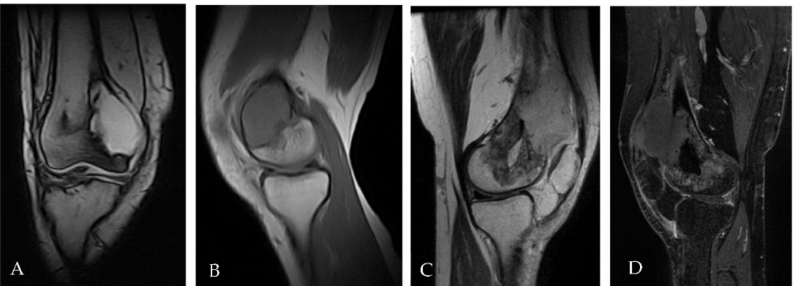
Figure 3. ( A , B ) MRI performed at time of initial diagnosis showed a focal eccentric lesion located in the meta-epiphyseal of distal right femur without interruption of cortical bone and/or involvement of neighbouring soft tissue. ( C , D ) MRI performed after surgery with curettage six months later showed the presence of solid heterogeneous high signal tissue in T2 (3C) enhancing post contrast (3D) with large extension in the soft tissue compatible with